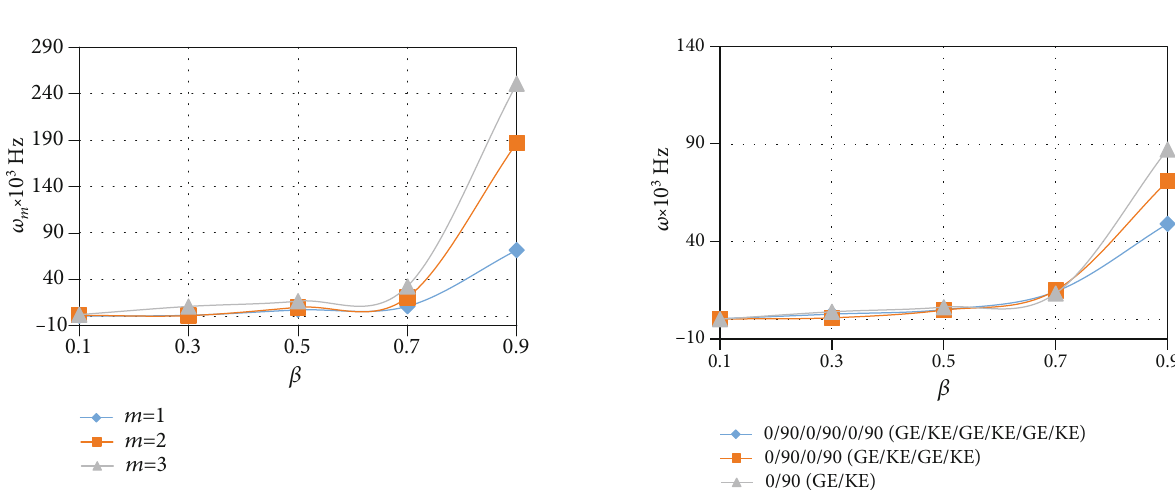
Figure 7: Variation of angular frequency and radius ratio of 6-, 4-, and 2-layered annular circular plates. S-S.